Question: Write the caption for this figure.
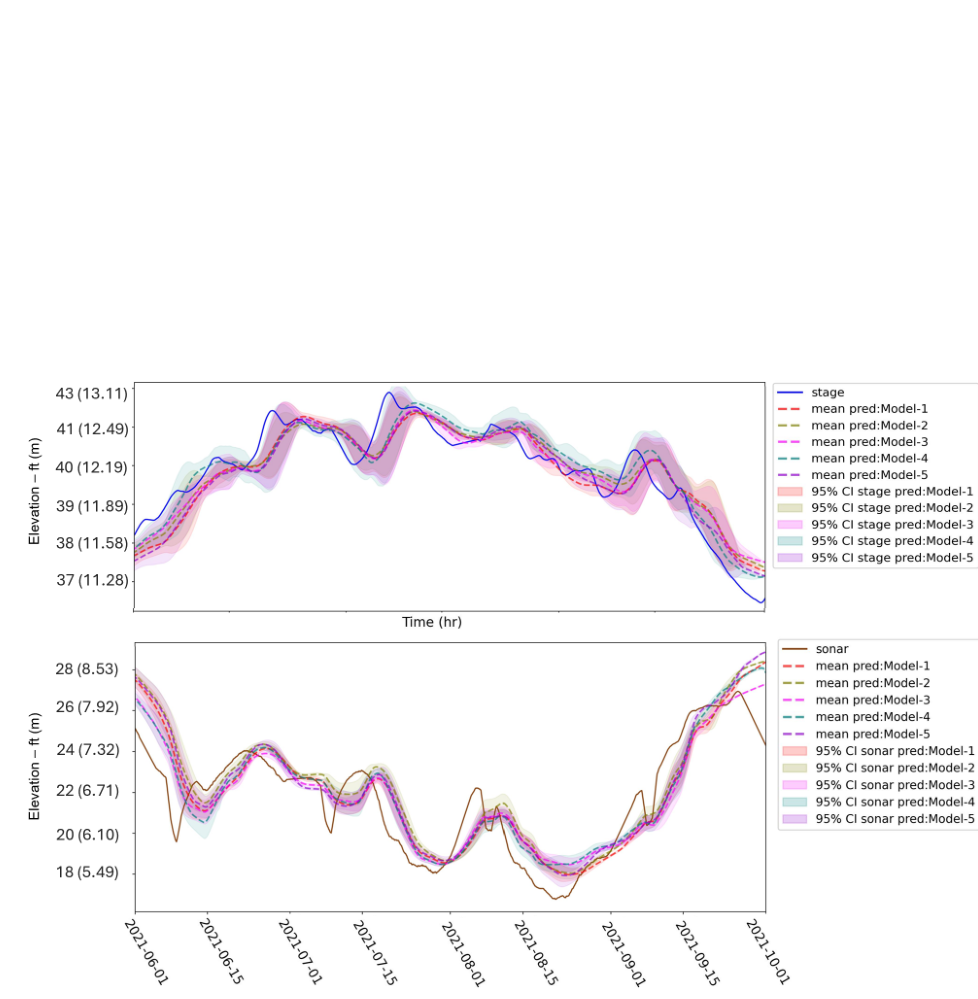
Answer: Stage (top) and Sonar (bottom) predictions of top-5 LSTM models selected by the random-search (bagging policy), mean and 95% confidence intervals over the test dataset - Alaska bridge 539.